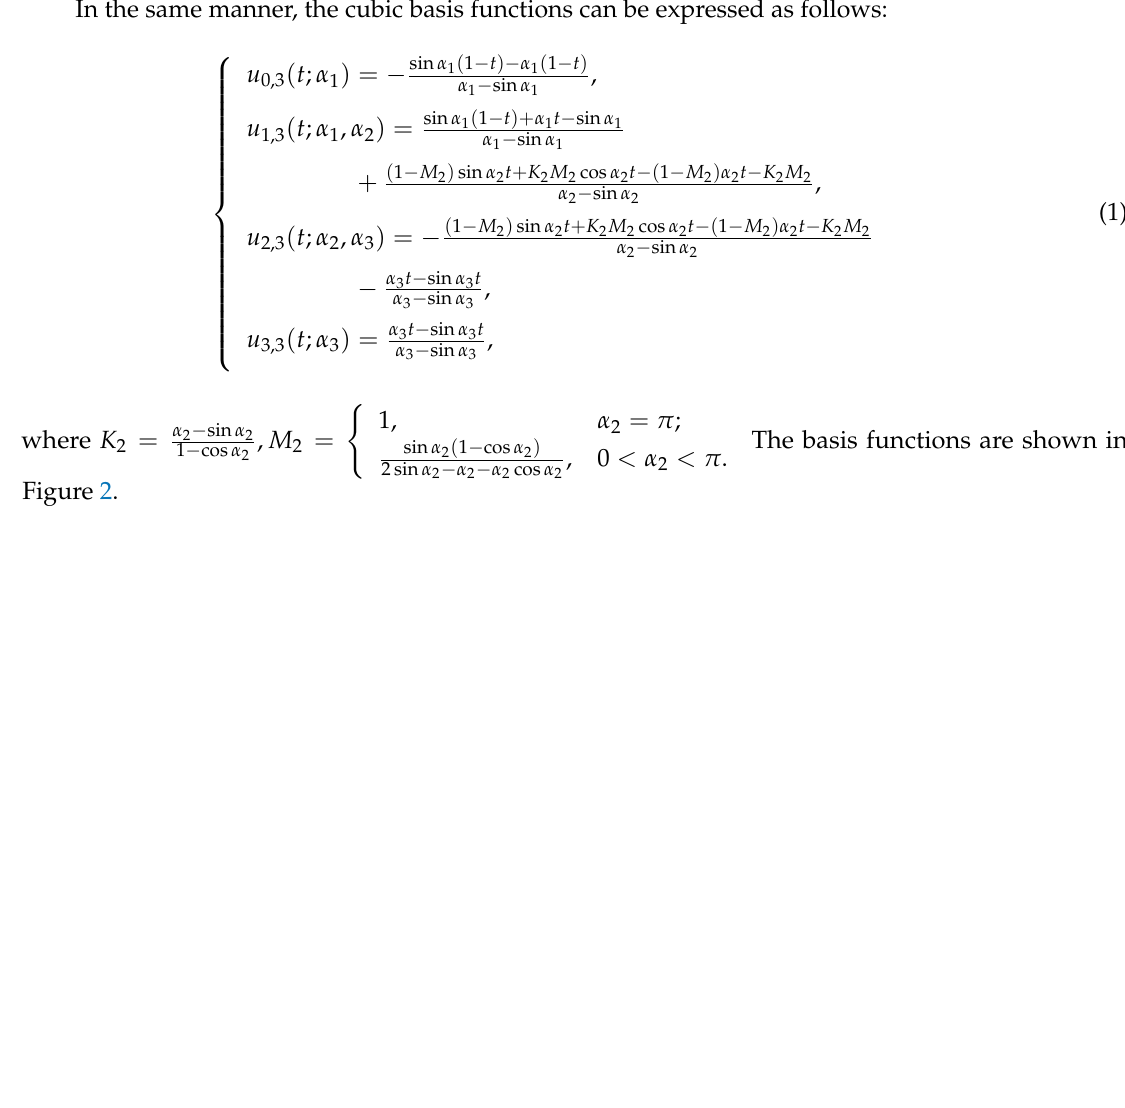
, α 2 = 7 π ; ( c ) α 1 = 7 π 8 8